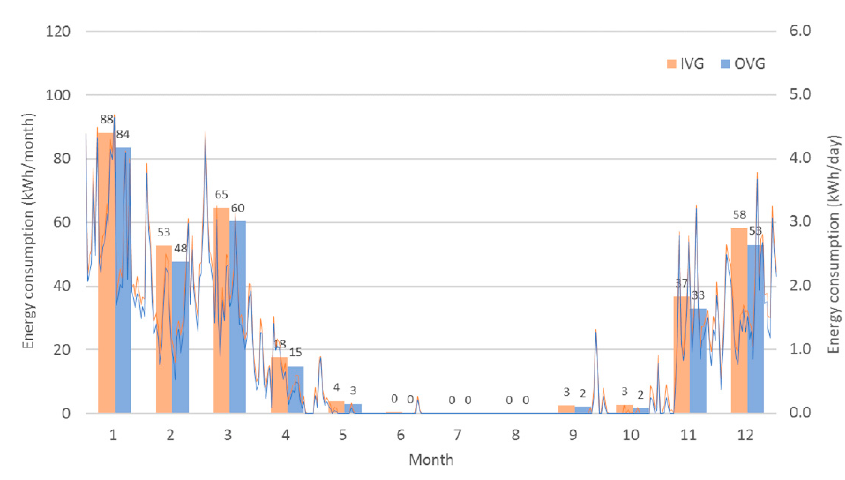
Figure 12. Calculated heating energy consumption of the IVG and OVG.